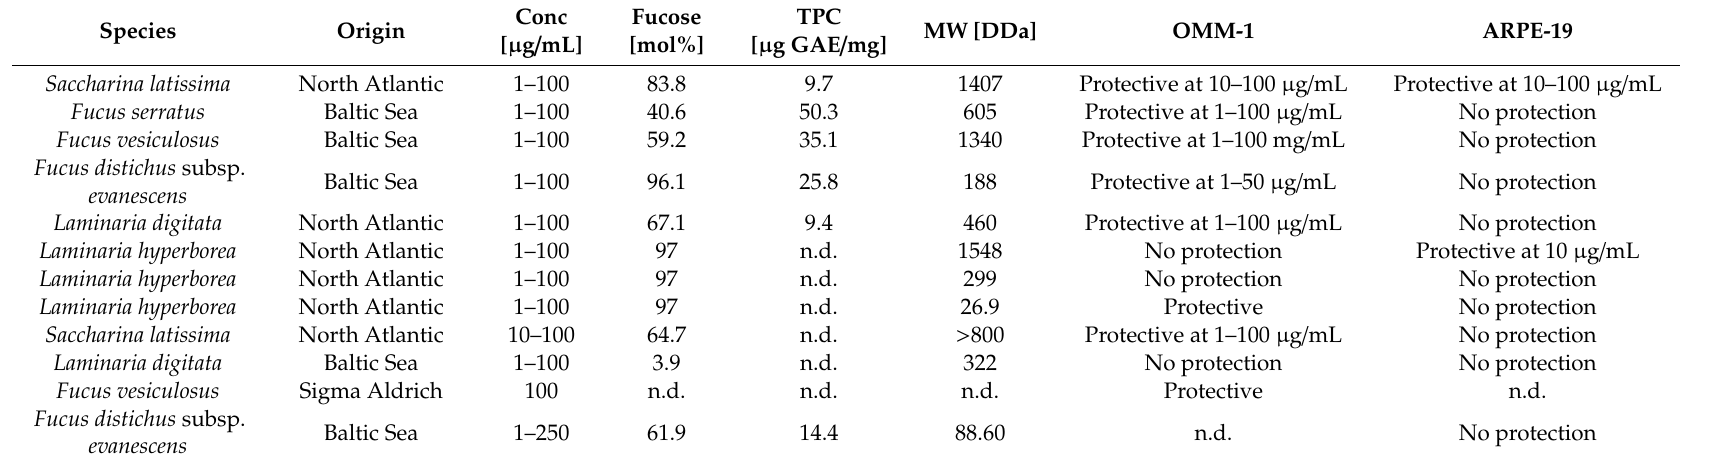
Table 2. List of tested fucoidans, oxidative stress